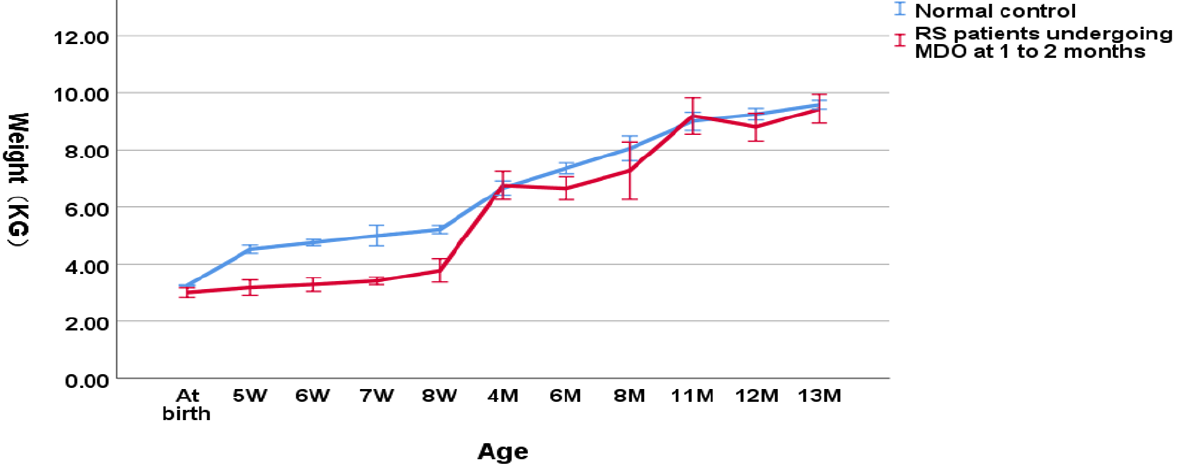
RS patients was decreasing significantly compared to the normal controls (3.41 ± 0.50 kg versus 4.80 ± 0.37 kg, p < 0.001 for the weight at the timing point of MDO and 3.81 ± 0.58 kg versus 5.36 ± 0.48 kg, p < 0.001 for the post-discharge weight). At the timing point of distractor removal, the weight of RS patients was close to the normal controls (6.82 ± 0.98 kg versus 7.37 ± 0.75 kg, p = 0.033). At aged one year, the weight of RS patients didn’t show a significant difference compared to the normal controls (9.12 ± 0.91 kg versus 9.33 ± 0.46 kg, p = 0.100).